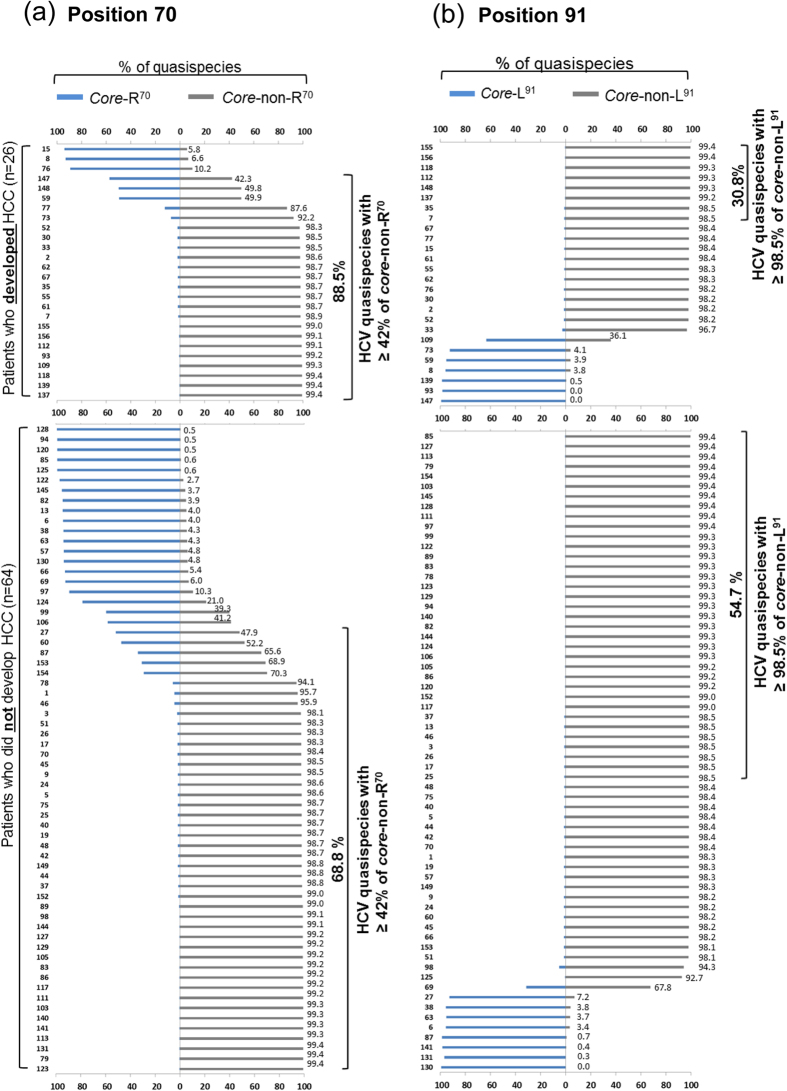
Proportion of baseline HCV core quasispecies at positions 70 (a) and 91(b) among patients who later developed HCC (n = 26) and patients who did not develop HCC (n = 64) as determined with Illumina-MiSeq data. Top and bottom axes of each panel indicate the percentage of quasispecies for core-R70, core-non-R70, core-L91 and core-non-L91. The exact percentage of core-non-R70 and core-non-L91 quasispecies are indicted at the end of each bar. Baseline samples containing quasispecies cut-points at ≥42% for core-non-R70 or at ≥98.5% for core-non-L91 are bracketed on the right side of each panel and indicate their frequency within HCC or non-HCC patients.